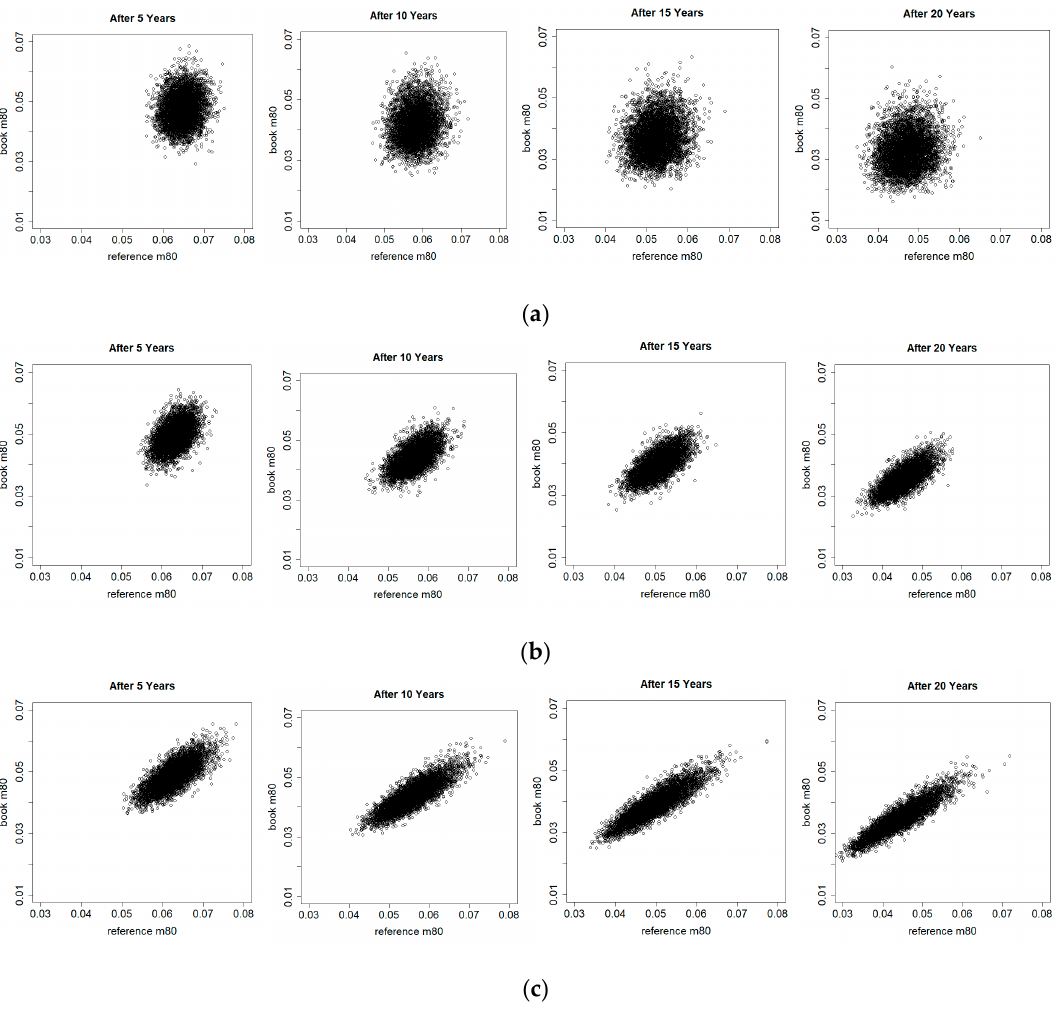
Figure 8. Simulated book and reference central death rates at age 80 after 5, 10, 15, and 20 years from residuals bootstrapping using pensioners (book) data and England and Wales (reference) data under ( a ) Model (1a); ( b ) Model (2a); ( c ) Model (3a).